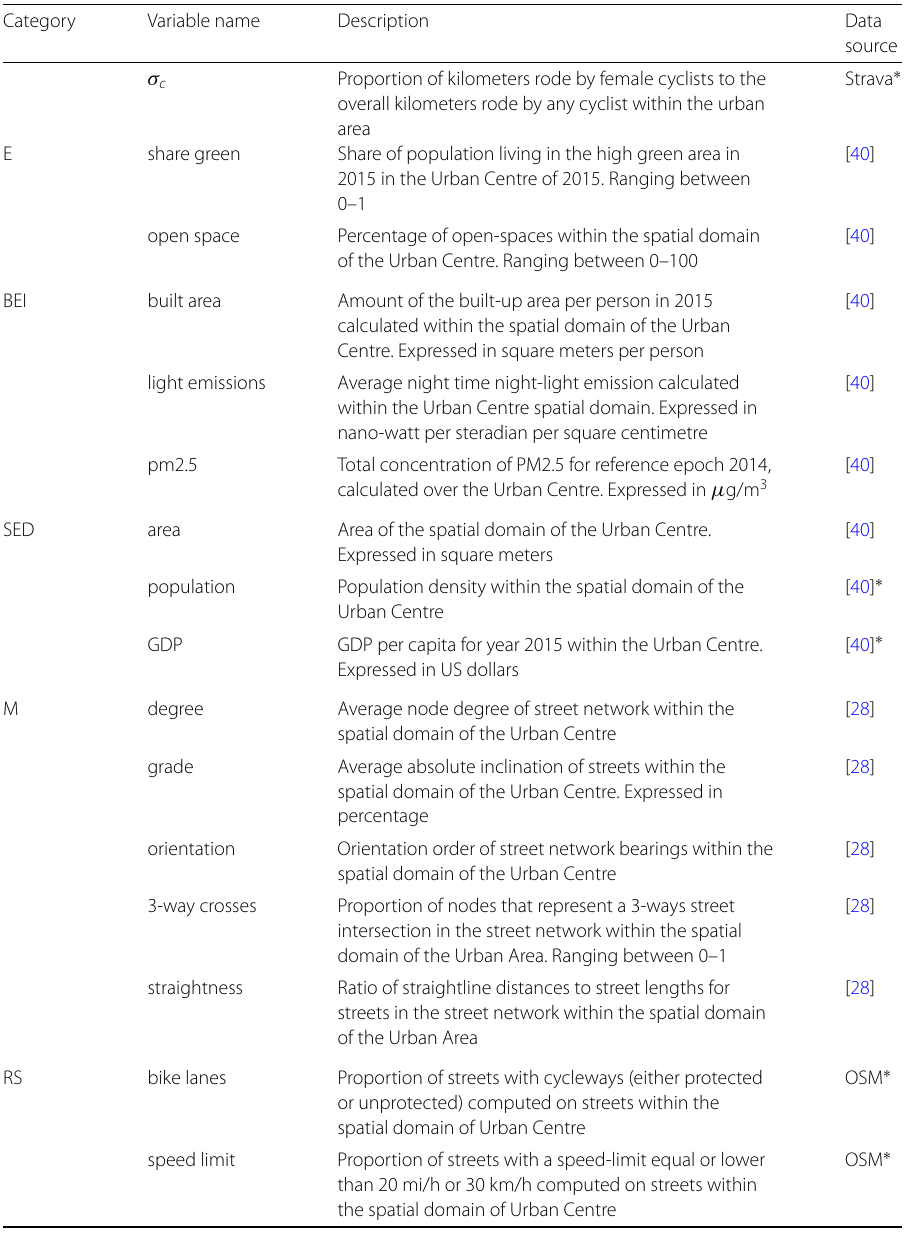
Table 1 City-level indicators: description and source